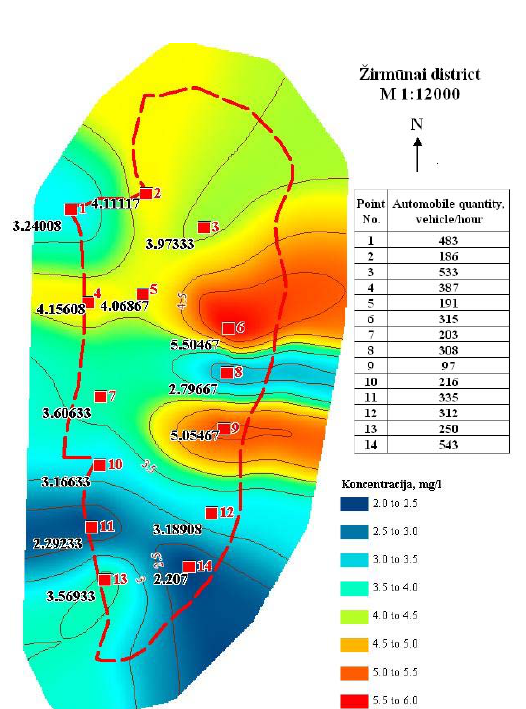
Fig. 5 . Geographical spread of common pollution of heavy metals in sweeps around sampling points in Žirm ū nai